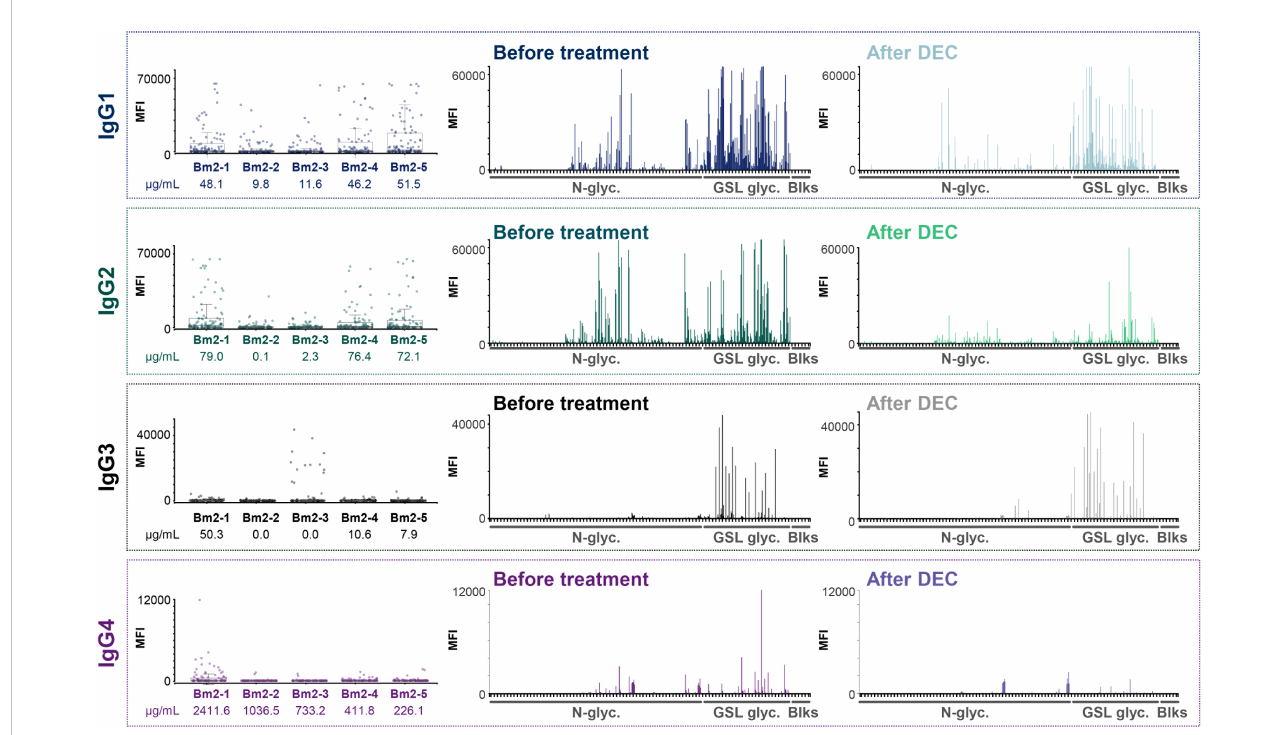
FIGURE 5 IgG subclass responses to B. malayi glycans in plasmas from infected individuals before and after DEC anthelmintic treatment. B. malayi glycan microarrays were screened for binding of IgG subclasses in plasma of B. malayi -infected individuals during infection and after treatment with DEC anthelminthic when individuals were all amicro fi laraemic. Subclass speci fi c fl uorescent secondary antibodies were used for detection of IgG subclass binding. Obtained background corrected MFI values are shown on the Y-axis of boxplots and graphs. Boxplots on the left show IgG subclass binding for all 5 individuals (ID numbers displayed on the X-axis, see Table S1.A) to each glycan fraction on the array (n = 100 with various printing concentrations and including buffer spots). BmA-speci fi c IgG1-4 titers from the original study (14, 29) are depicted in µg/ml for each individual below their corresponding ID number underneath the boxplots. Graphs show overall IgG binding to the various glycan array fractions (X-axis, n = 100) for plasma from all 5 individuals either during infection (Before treatment, left) or after DEC treatment (After DEC,